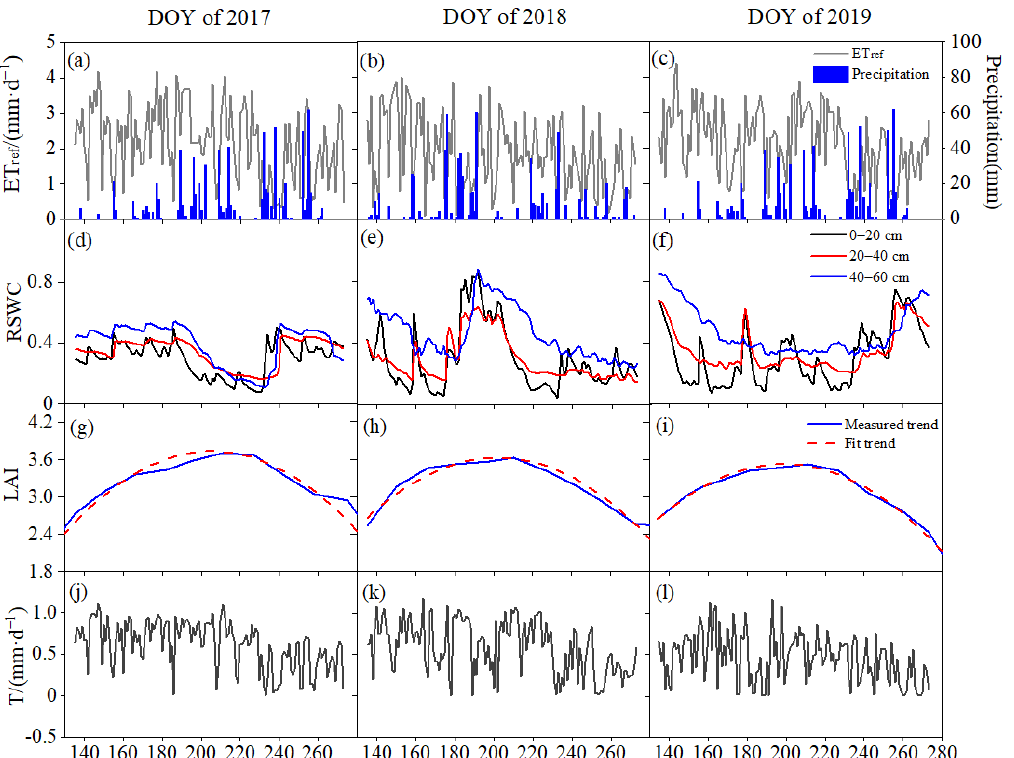
Figure 2. Daily variations of environmental factors (ET ref and precipitation ( a – c ), RSWC at a depth of 0–20, 20–40, 40–60 cm ( d – f ), LAI ( g – i ), and T ( j – l )) during the study periods in the plot of L. principis - rupprechtii from 2017 to 2019.